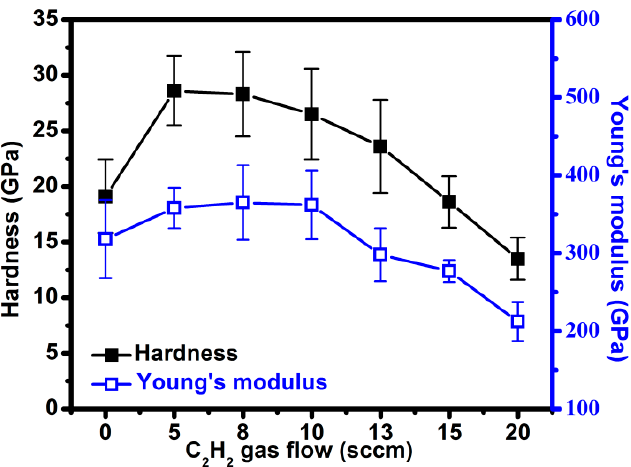
Figure 5. Nanoindentation results (hardness and Young’s modulus) as a function of C 2 H 2 gas flow rate.